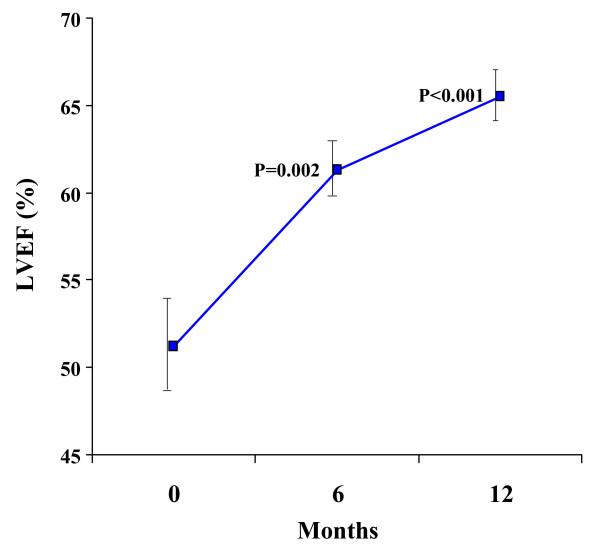
There was a significant improvement in LV ejection fraction over 12 months. Standard error bars are shown. The p values shown are post-hoc analyses for 0–6 months, and 0–12 months.